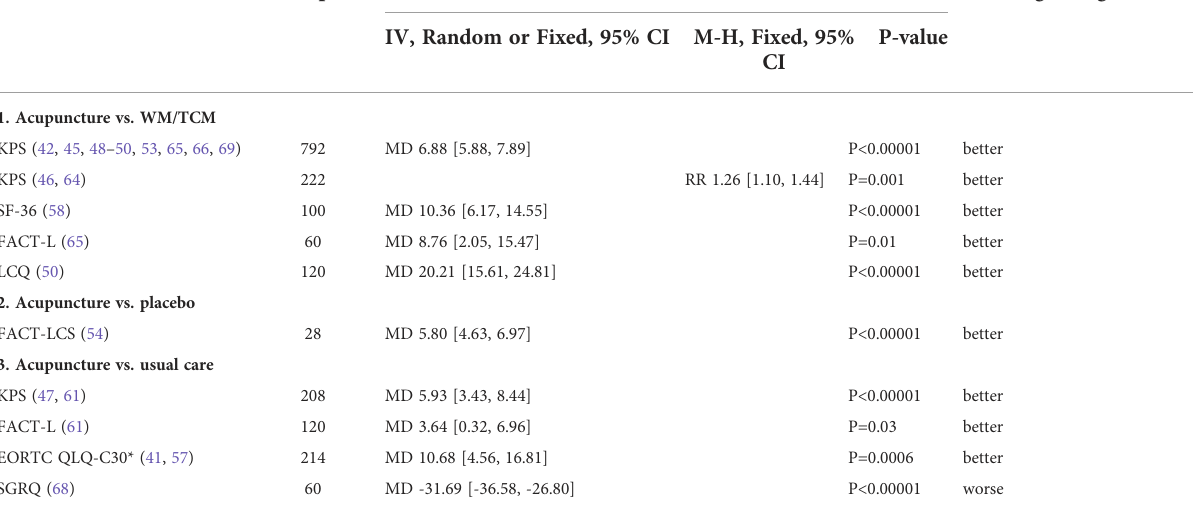
TABLE 4 The effect of acupuncture on the QOL compared to different comparators.